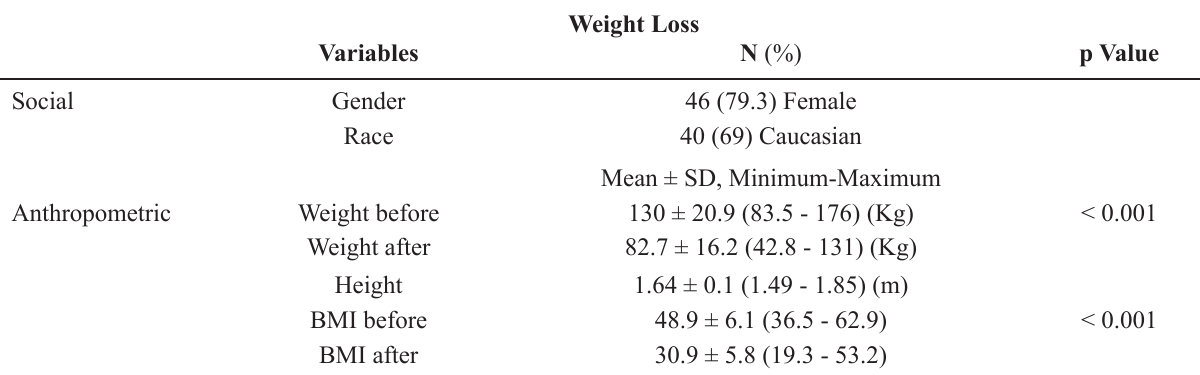
Table 1 – Social and anthropometric information before and after excessive weight